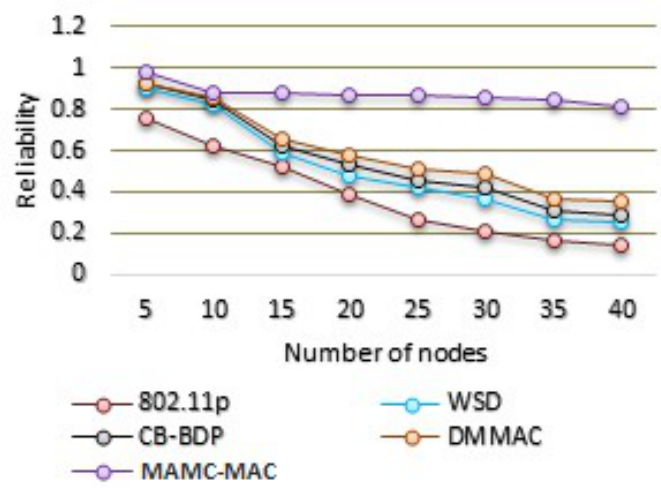
Figure 11. Reliability comparison.